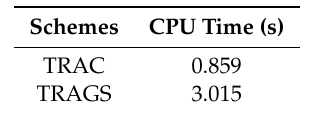
Figure 7. Total utility with different schemes combination. Table 2. CPU times with different tile bit rate assignment